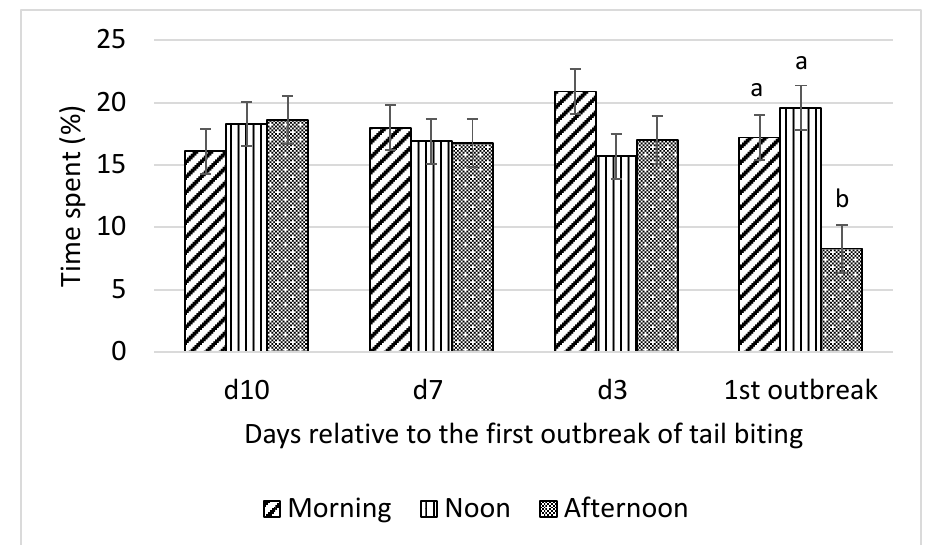
Figure 5. Interaction between day (10 d, 7 d, and 3 d before and during) relative to the first outbreak of tail biting and time of day (morning, noon, and afternoon) for time spent standing (% of observation time); ab —within days means without a common superscript differ ( p < 0.01).